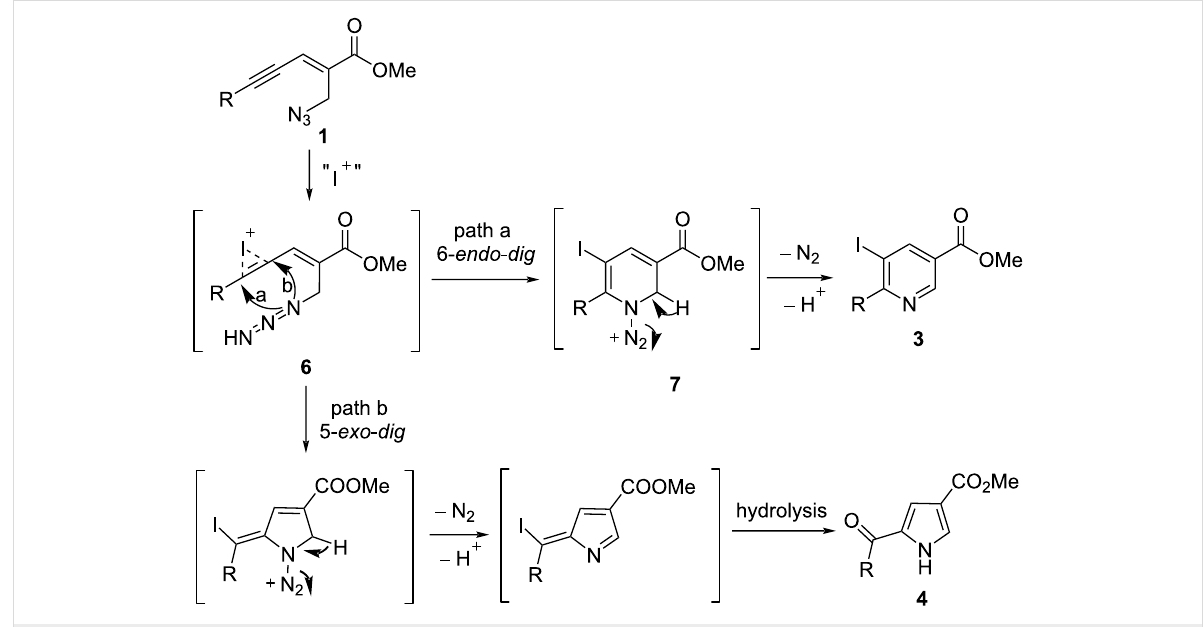
Scheme 3: The proposed mechanism of I 2 -mediated aza-annulation.